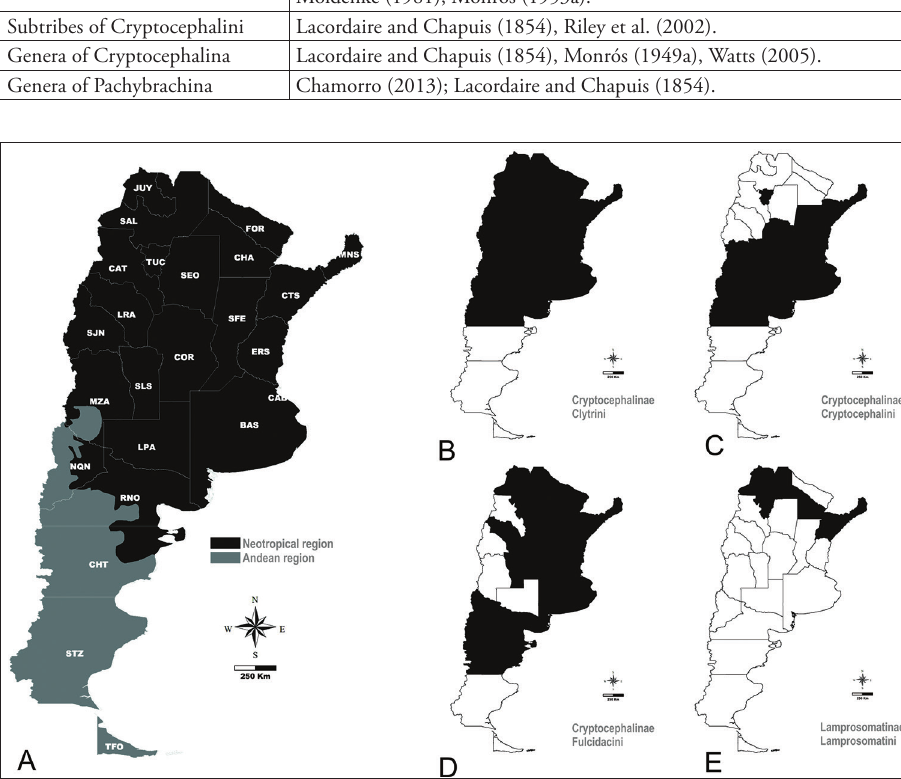
Figure 1. Distribution of Camptosomata tribes. A Map showing Argentinian administrative divisions with abbreviation as used in text. Andean and Neotropical regions as indicated in color reference B In black, administrative divisions containing Clytrini species C In black, administrative provinces contain- ing Cryptocephalini species D In black, administrative divisions containing Fulcidacini species E In black, administrative divisions containing Lamprosomatini